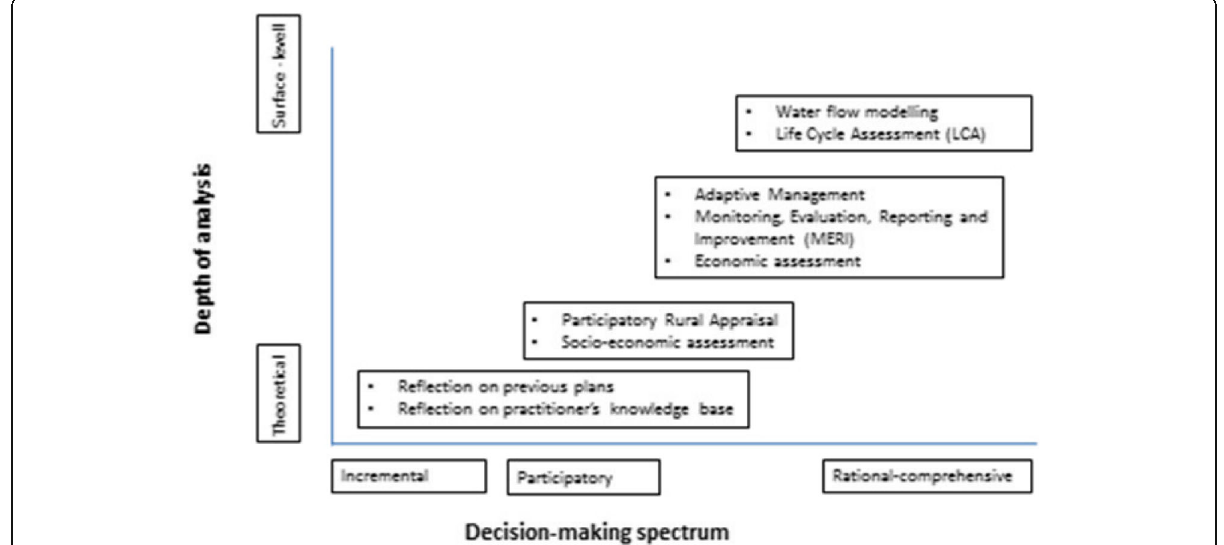
Fig. 1 Conceptualising a new paradigm by classifying the intent of existing decision-making processes on the spectrum of approaches from planning